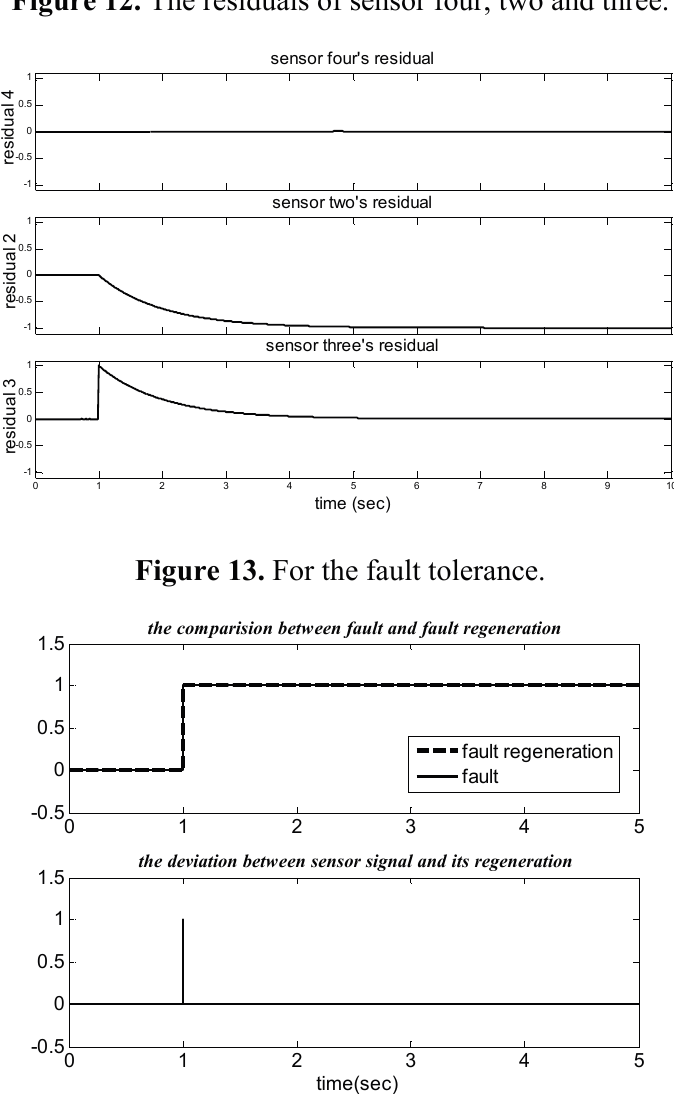
Figure 12. The residuals of sensor four, two and three.